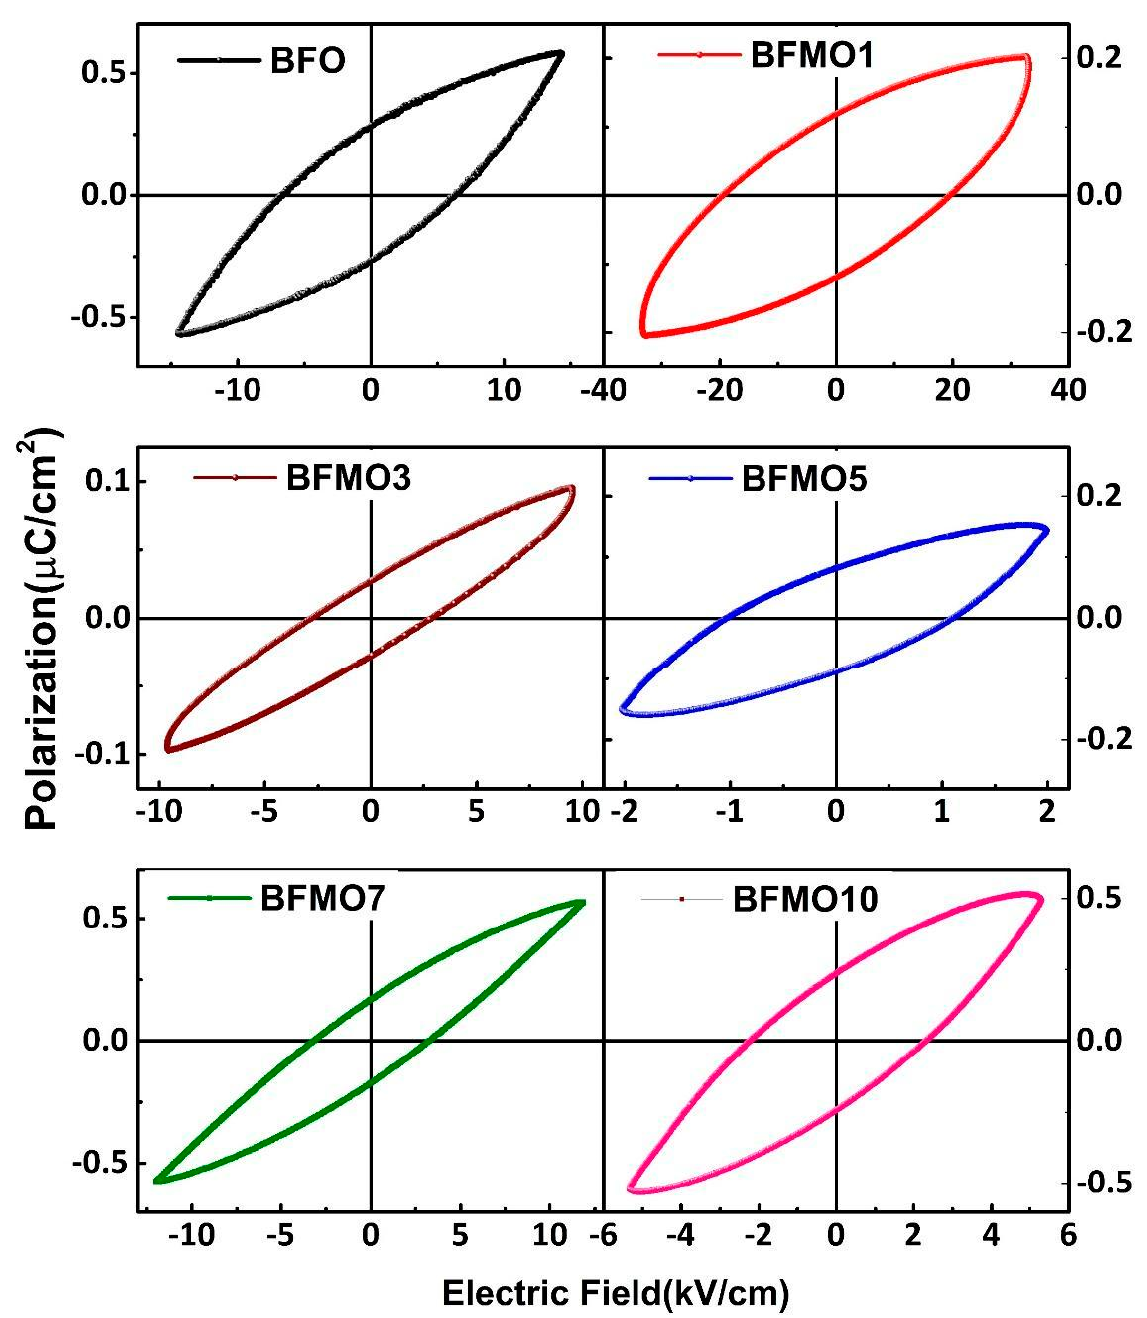
Figure 5. P-E hysteresis loops of BFO, BFMO1, BFMO3, BFMO5, BFO7, and BFMO10.